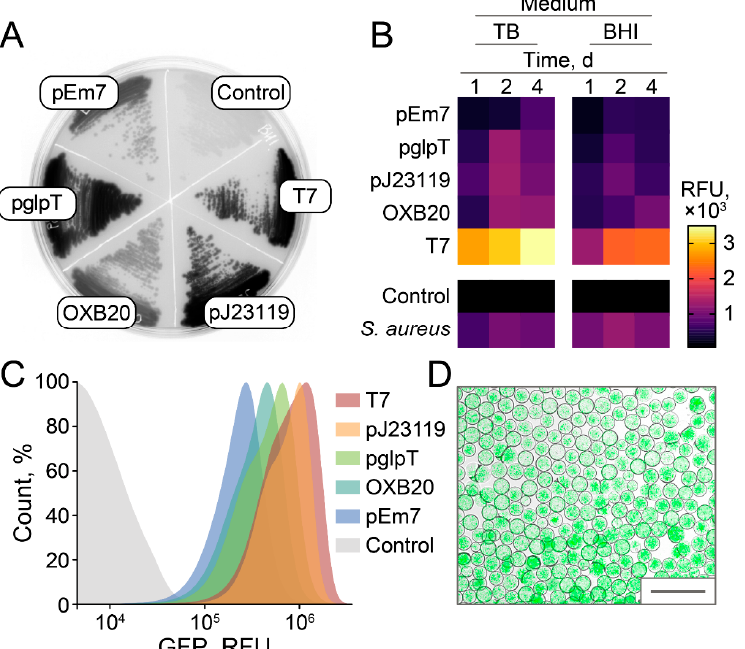
Figure 5. Efficacy of different promoters for constitutive and homogeneous production of GFP in E. coli . ( A ) A representative BHI-agar plate with E. coli, producing sfGFP under control of various pro- moters. Constitutive E. coli promoters, i.e., pEm7, pglpT, pJ23119, and OXB20, were compared with leaking T7. E. coli cells transformed with empty vector without sfGFP insert were used as a negative control. ( B ) Fluorescence of bacterial cultures obtained after 1, 2, and 4 days of cultivation in TB or BHI medium. Relative fluorescence units (RFU) are presented as a heatmap indicating bulk fluores- cence of cell cultures. GFP-producing reporter S. aureus cells were used as a positive control. Data represent the mean of three biological replicates. ( C ) Flow cytometry of bacterial cultures producing sfGFP obtained after 2 days of cultivation in BHI medium. ( D ) Live biosensors producing sfGFP under control of pJ23119 promoter after 1 day of cultivation in droplets of microfluidic double wa- ter-in-oil-in-water emulsion. Scale bar: 100 μ m.